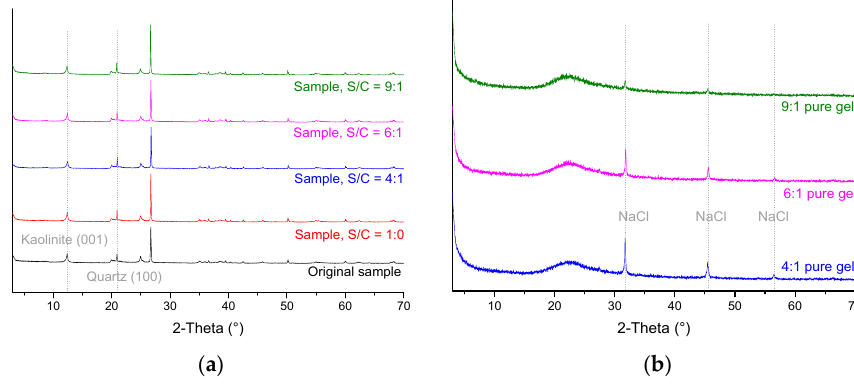
Figure 4. XRD results. ( a ) XRD scans showing peak positions and intensities for one untreated mudstone sample and four mudstone samples impregnated with different mixtures of silica sol grout; and ( b ) XRD test of the pure gel, the peak occurred at 20.9° or so (2-theta of quartz (100)) is too wide. Table 2. Peak specific parameters and lattice spacings for kaolinite (001) and quartz (100).